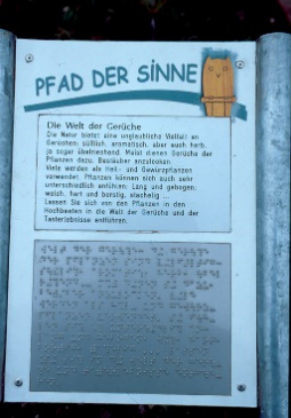
Figure 16. Representation of geological time spans in Dinoplagne (France) (Megerle 2022).